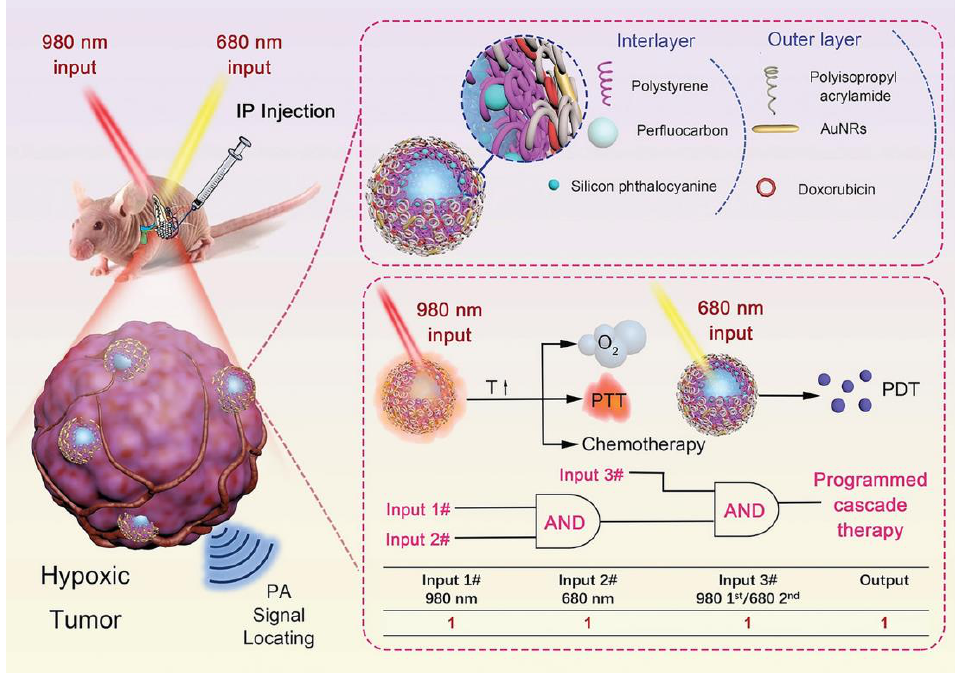
Figure 5. Schematic diagram of PSPP-Au980-D-mediated controllable release of “oxygen bomb” and programmed cascade therapy process. Reprinted with permission from [132]. Copyright 2022, John Wiley and Sons.